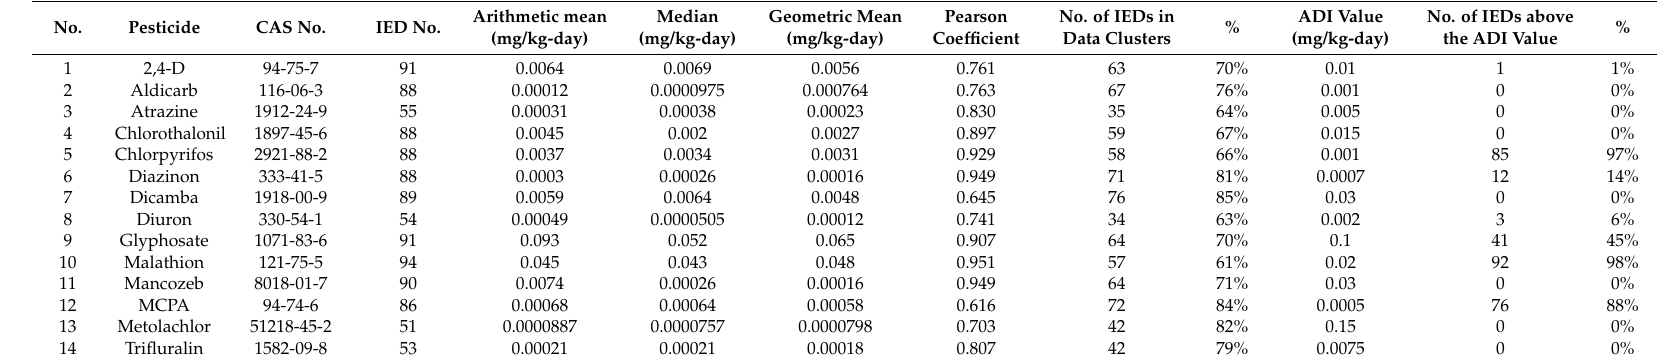
Table 7. Statistical summary of IEDs for the widely used pesticides.